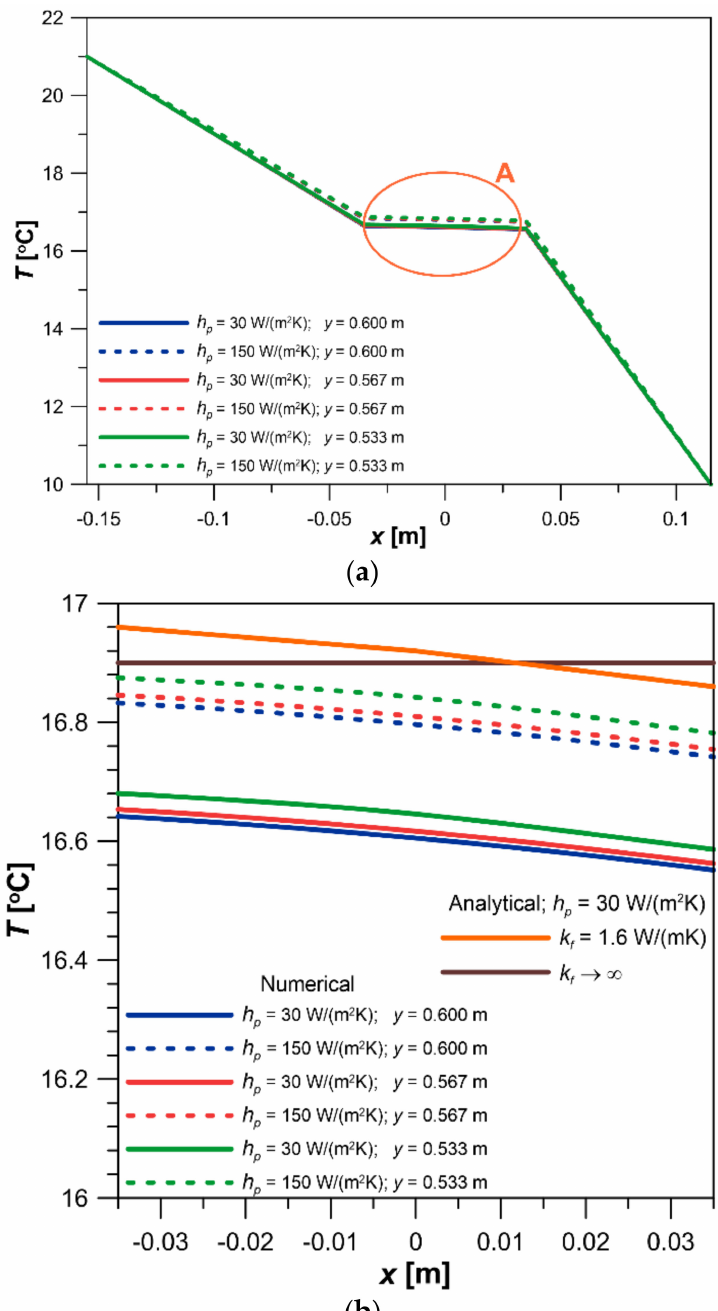
Figure 7. ( a ) Temperature profiles in the individual envelope layers; ( b ) temperature profiles in the layer with a heat